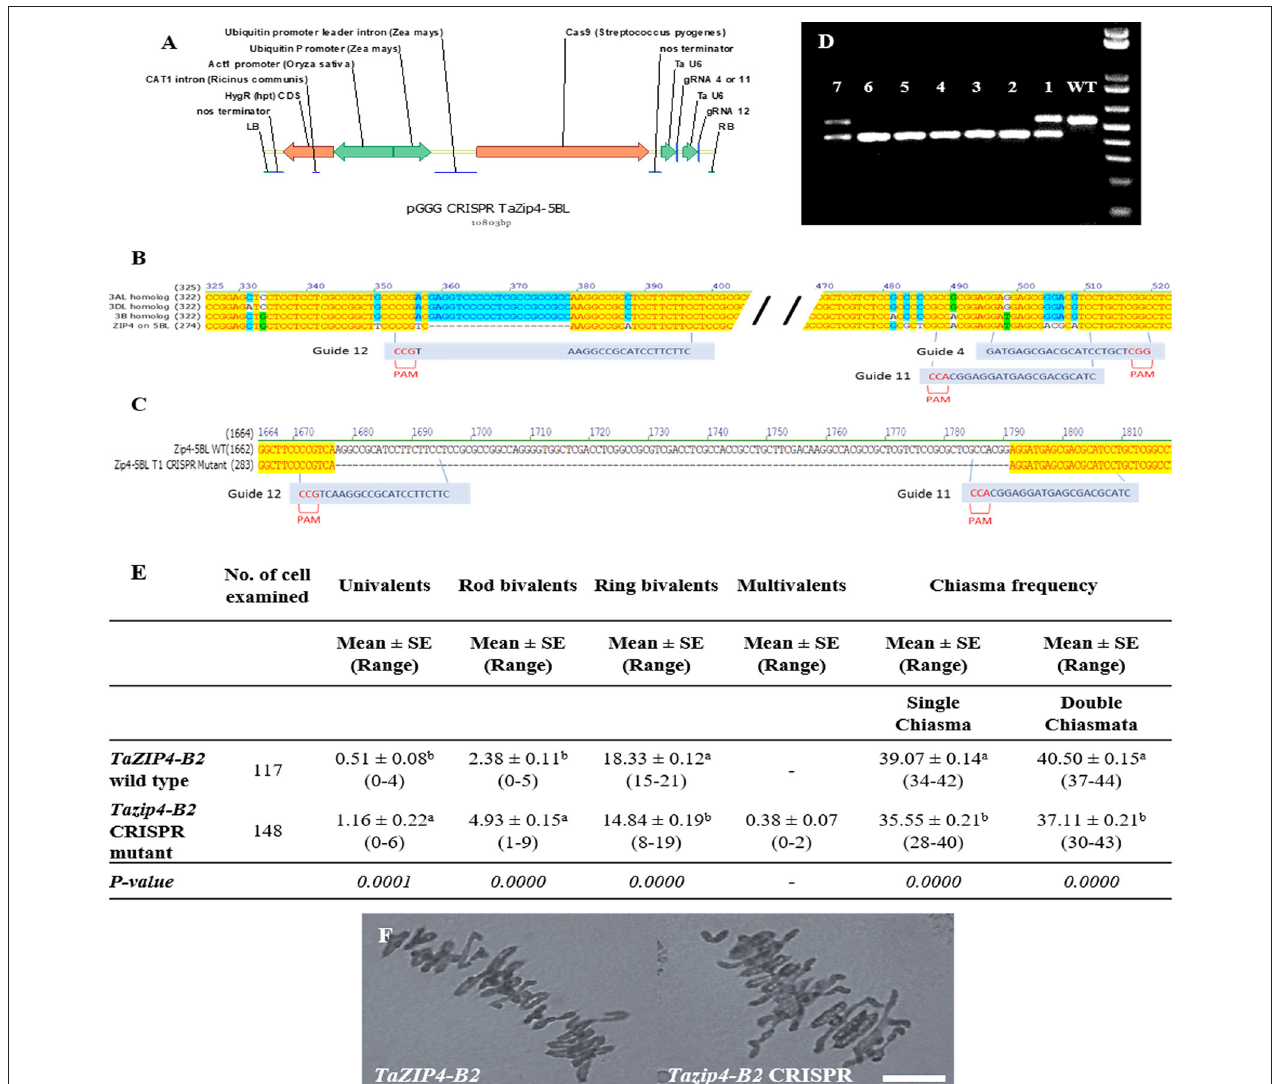
FIGURE 3 | Development and phenotypic analysis of Tazip4-B2 CRISPR mutants generated using RNA-guided Cas9. (A) Schematic of the structure of the pGGG CRISPR TaZip4-B2 vector used in this study. (B) Alignment of all copies of the ZIP4 gene in wheat showing sequences and positions of the three sgRNAs designed to specifically target TaZIP4-B2 with their corresponding protospacer-adjacent motif (PAM). (C) Alignment of TaZIP4-B2 wild type and Tazip4-B2 CRISPR mutant sequences sowing the localization of the large deletion (115 bp) in TaZIP4-B2 . (D) Genotypic assays for the identification of homozygous edited lines (lines: #2, #3, #4, #5, and #6) and heterozygous lines (lines: #1 and #7). Wild-type Fielder (WT) was used as a control line. (E) Frequencies of univalents, bivalents and multivalents, and total chiasma frequency (single and double chiasmata) were scored at meiotic metaphase I in wild-type Fielder and Tazip4-B2 CRISPR mutant. Values in parenthesis indicate range of variation between cells. P < 0.05 indicates significant differences according to Dunn’s test. Different letters indicate significant differences between treatments. (F) Representative meiotic metaphase I configurations of wild-type Fielder and Tazip4-B2 CRISPR Fielder mutants. Left: wheat cv. Fielder and right: Tazip4-B2 CRISPR mutant. Bar: 20 µ